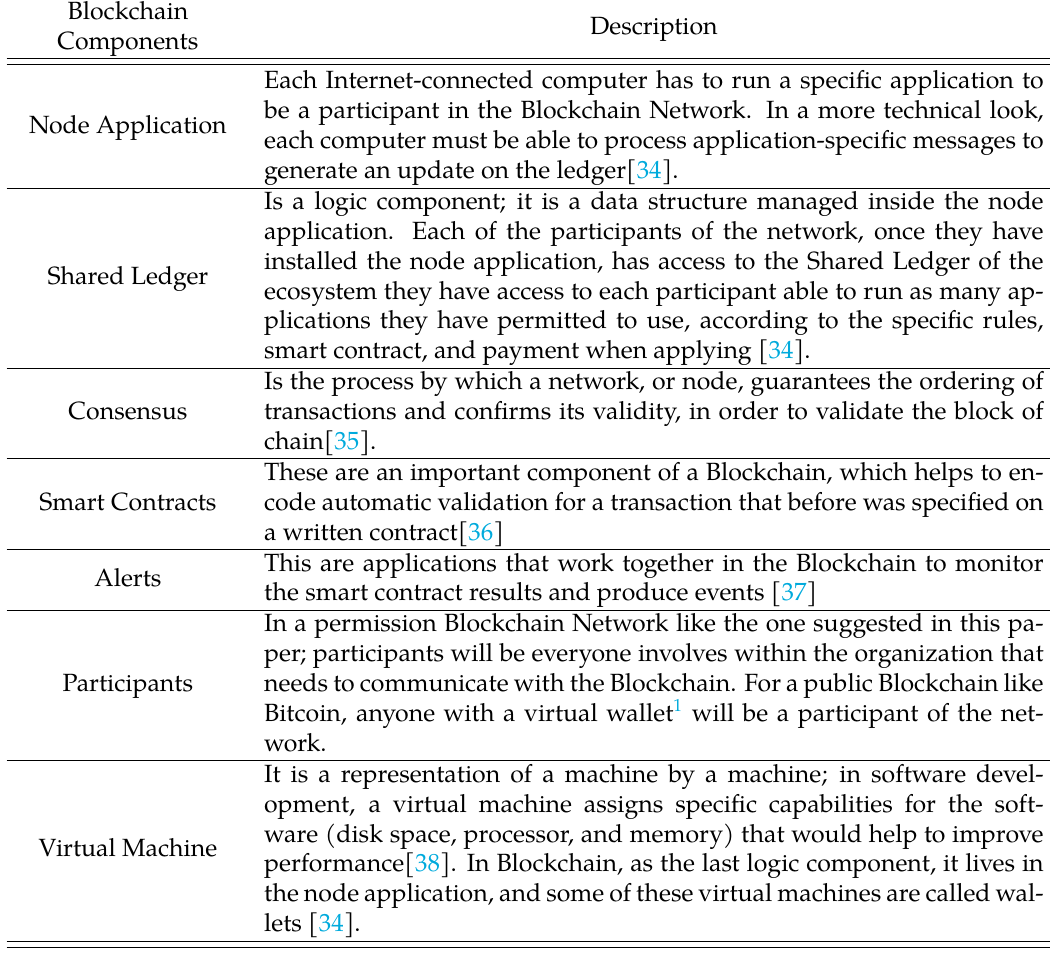
Table 2: Principal components of a Blockchain-software solution to support ISO